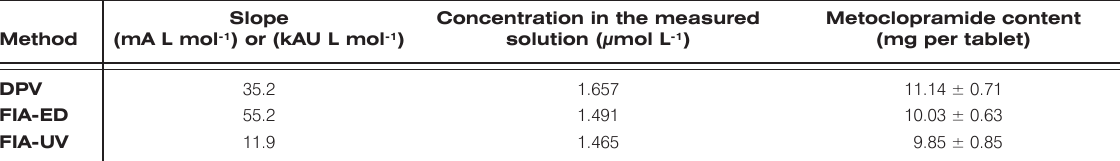
Concentration in the measured solution (µmol L -1 )